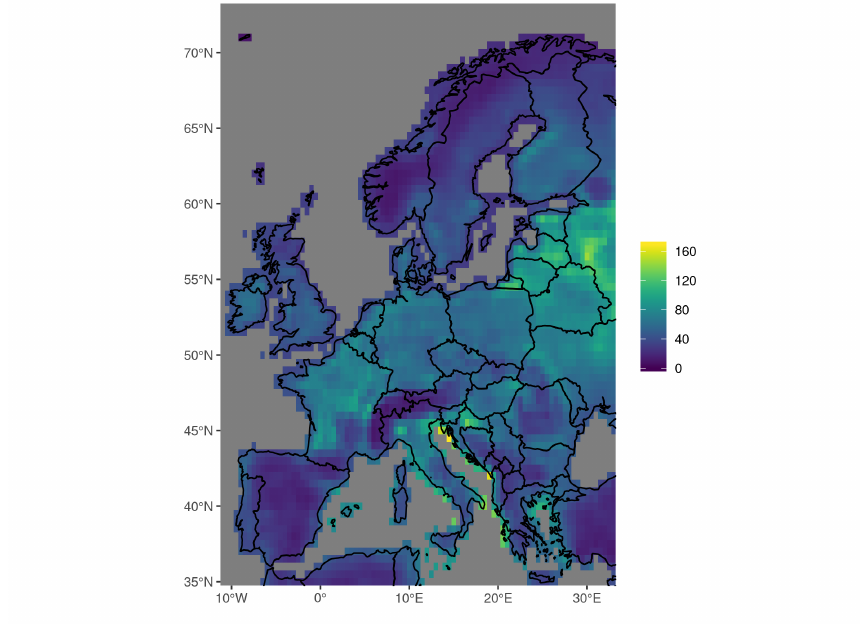
Figure 5. Tornado occurrence rate per 100 years and 10,000 km 2 obtained from the output of the two-parameter logistic regression model given by